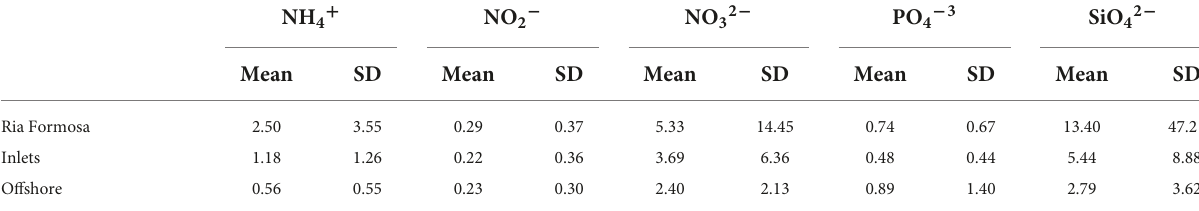
TABLE 3 Mean values and standard deviation of nutrient concentrations in n three different areas: the inside of the lagoon (Ria Formosa), the inlets that connect it with the sea (Inlets) and the offshore waters